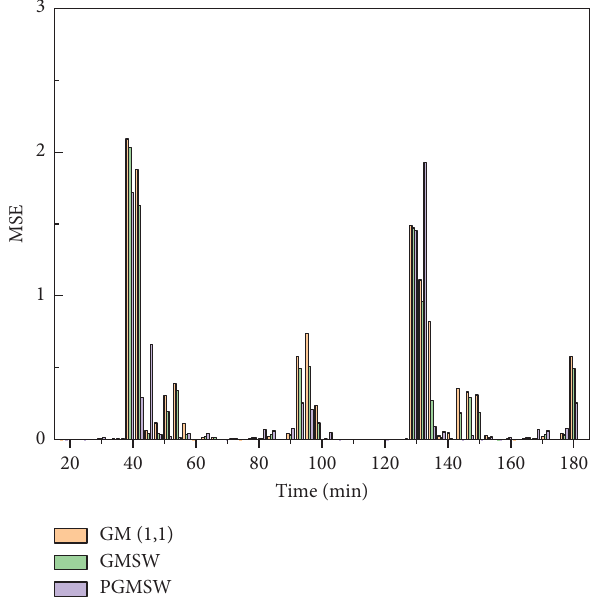
Figure 8: MSEs of the three models (window size �